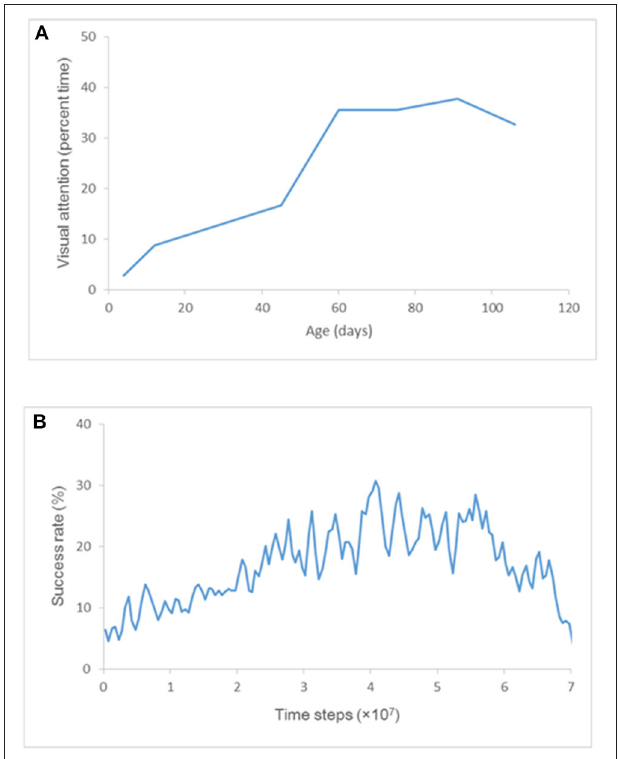
FIGURE 2 | Visual attention and success rate. (A) Development of visual attention for the subjects assigned to the control group. Each point represents “the average of two scores taken during successive 2-week periods” (White and Held, 1966). (B) Plot of an ensemble average of success rates obtained by training ten